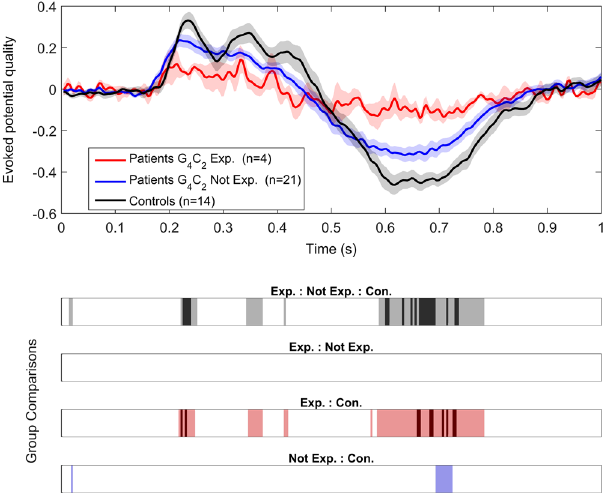
Figure 2. VEP quality is decreased in ALS, particularly in the presence of C9ORF72 expansion. Top: Mean quality of the evoked potential ( ± SEM) for controls and patients, with and without the expansion. Bottom: Windows where there exist significant differences in VEP quality between the three groups as well as three post- hoc pairwise comparisons. These differences are shown a the α = 0.05 level (light colors) as well as after FDR correction (dark colors).